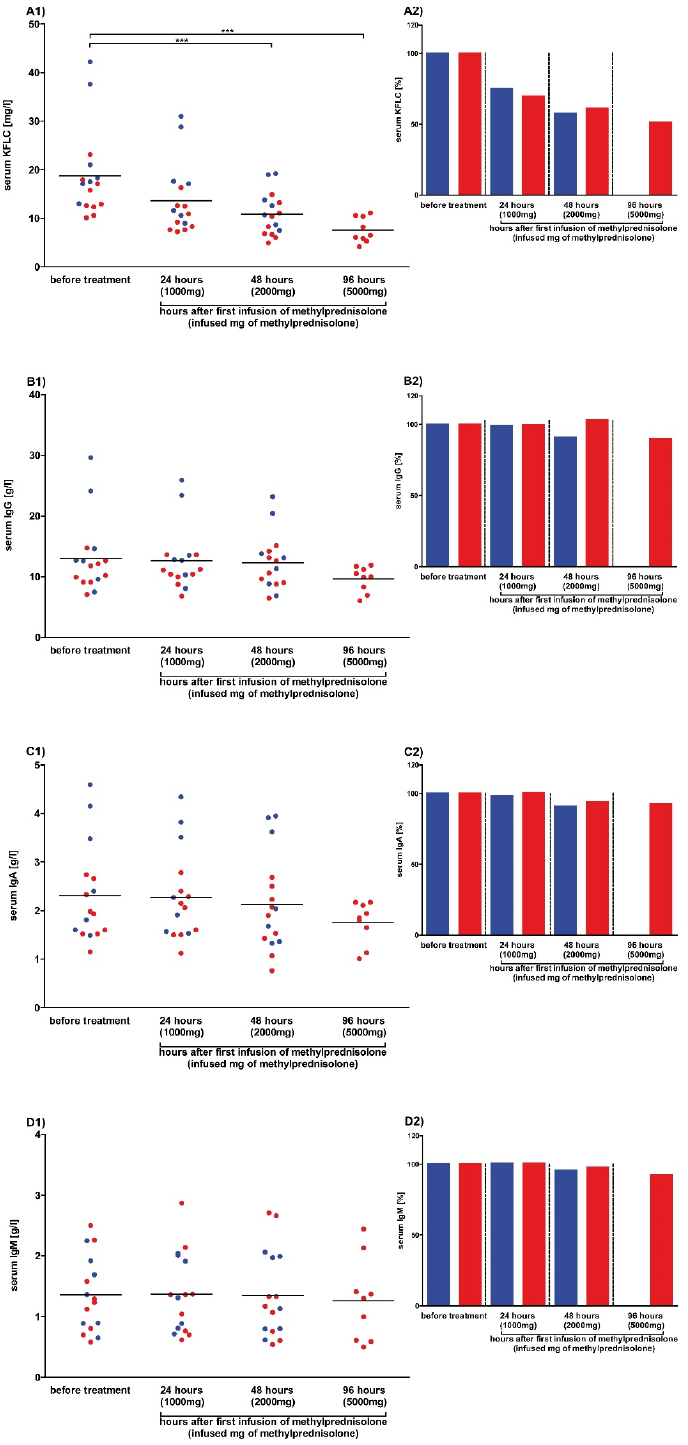
Figure 3. Serum concentrations after methylprednisolone in prospective patients. Serum concentrations of patients whose data and samples were collected in 2018 and 2019 are shown. Depicted are serum concentrations of kappa free light chains (KFLC) ( A1 ), immunoglobulin type G (IgG) ( B1 ), IgA ( C1 ), and IgM ( D1 ). The percentage decrease of concentrations of KFLC ( A2 ), IgG ( B2 ), IgA ( C2 ), and IgM ( D2 ) in serum is also shown. Patients treated with intravenous methylprednisolone for 3 days are depicted as blue dots and columns (n = 7), while patients with a treatment of 5 days are depicted as red dots and columns (n = 9). Blood samples were taken before and after 24, 48, and 96 h of treatment with 1000 mg of intravenous methylprednisolone per day. p -values of significant differences are illustrated as